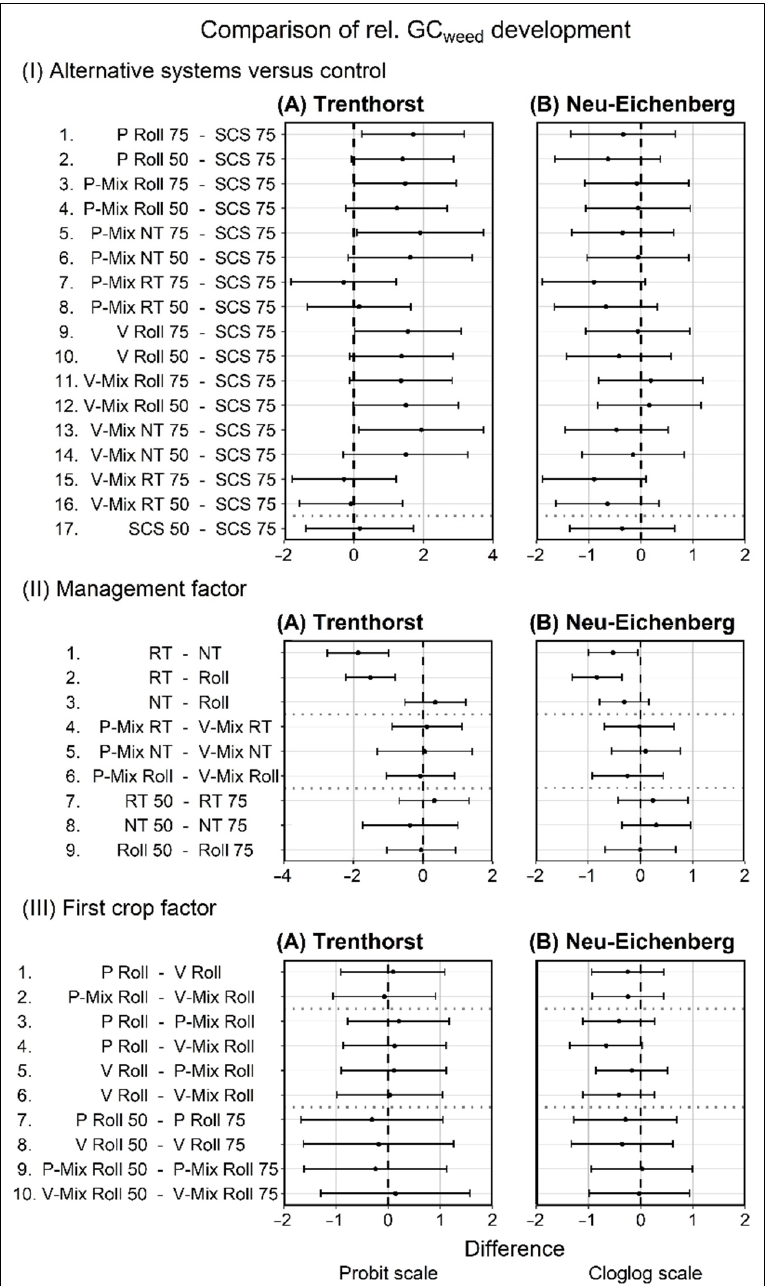
Figure 3. Comparison of relative weed groundcover (GC weed ) averaged over year at the two locations with the foci: ( I ) Alternative systems versus control, ( II ) Management factor, ( III ) First crop factor. The contrast in question is shown on the y-axis, whereas its scale is on the x-axis. Factor levels for first crop are: P = winter pea, V = hairy vetch, P-Mix and V-Mix = their mixtures with a cereal partner; for management are: SCS = control, RT = reduced tillage, NT = no tillage, Roll = rolling of first crop; and for row width are: 75 cm and 50 cm. Points represent the linear contrasts of mean estimates as subtraction (on probit or cloglog scale). The vertical dashed lines at 0 show the H 0 , where the difference of estimates is 0 (estimated means are equal). Error bars show the 95% CI of the estimated difference after multivariate t adjustment. Thus, when this crosses the vertical dashed line (H 0 ), there is statistically no or non-significant difference between means at α = 0.05. Each focus group is analyzed independently. Please note that DCS NT treatments at TRE were only present in the second year.